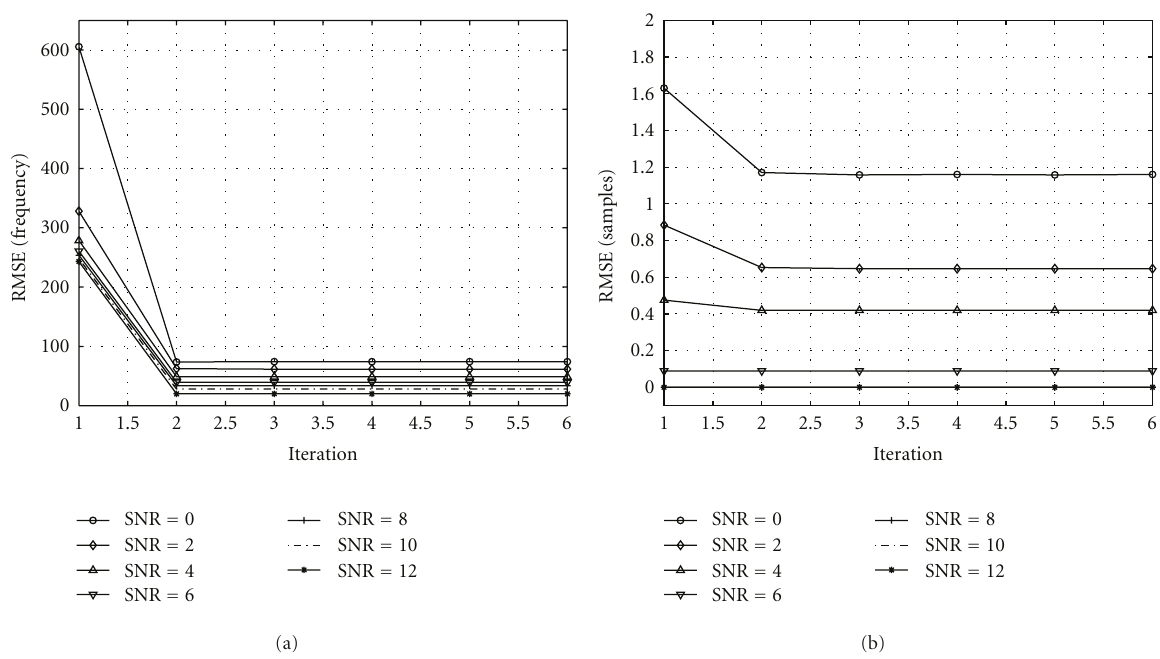
Figure 3: Number of iterations versus estimation error with K = 120. (a) Frequency estimation error. (b) K estimation